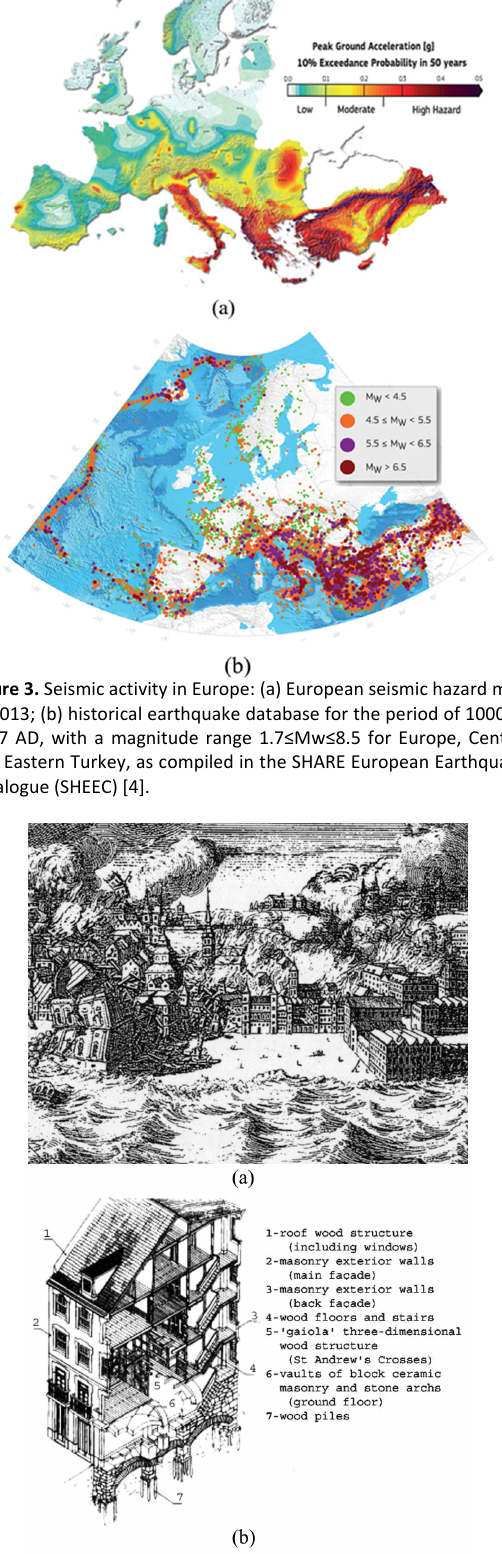
Figure 4. Lisbon earthquake 1755: (a) representation of the tsunami and fire, after the earthquake, from a German engraving [5]; (b) perspective drawing of a typical ‘Pombalino’ building, post to the earthquake